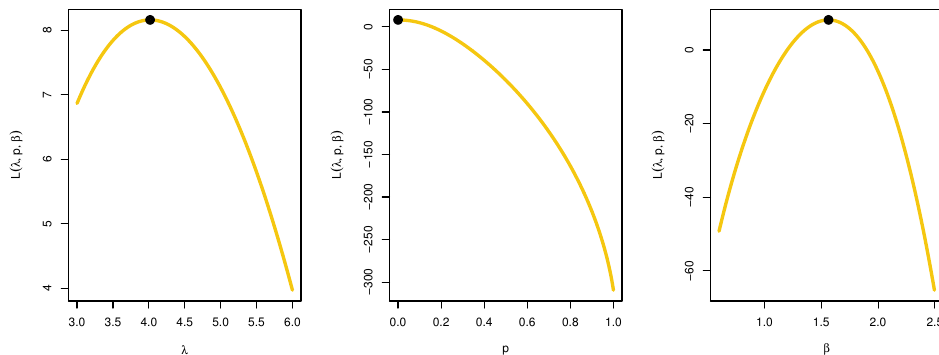
Figure 16. Profile likelihood for third